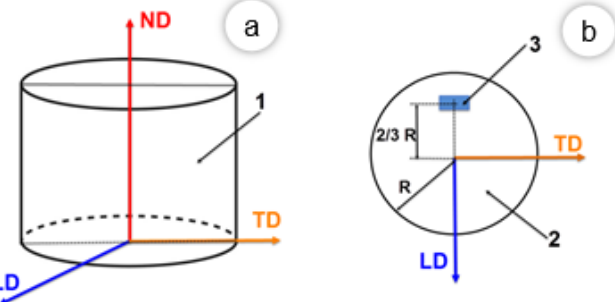
Figure 1. Schematic representation of the reference system of the analysed samples, showing position of the sample’s reference system ( a ) and, position of selected area for SEM-EBSD analysis ( b ); 1—initial sample; 2—LD-TD section from the middle of the sample; 3—position of the investigated SEM-EBSD area; LD—longitudinal direction; TD—transverse direction; ND—normal